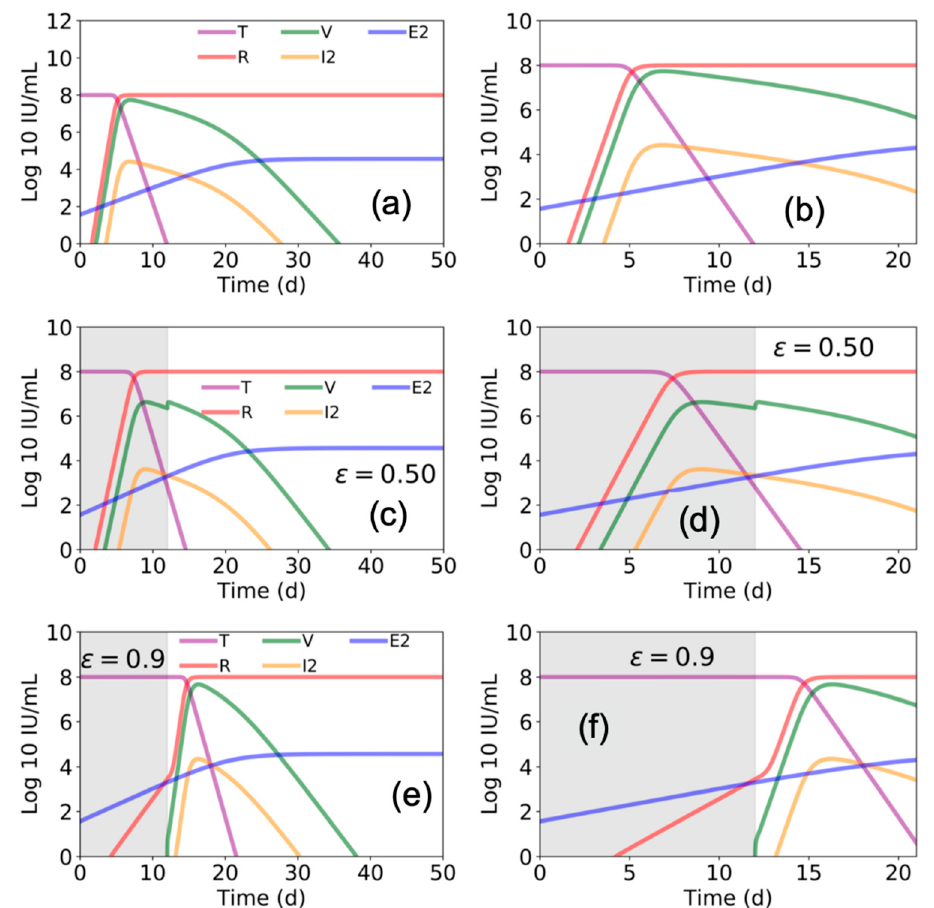
Figure 3. Estimated Ebola virus–host dynamics with and without antiviral treatment. Using parameter values presented in Figure 3 and Table 1 in Madelain et al. [4], we plot the values of target cells (T), viral load (V), refractory cells (R), productive infected cells (I2), and EBOV specific T cells (E2) with ( a , b ) zero antiviral efficacy ( ε = 0), ( c , d ) with 50% efficacy ( ε = 0.5), and ( e , f ) with 90% antiviral efficacy ( ε = 0.9). Estimates over 50 days are shown in ( a , c , e ) and a zoom of the first 21 days are shown in ( b , d , f ). Gray shaded areas indicate duration of antiviral treatment.